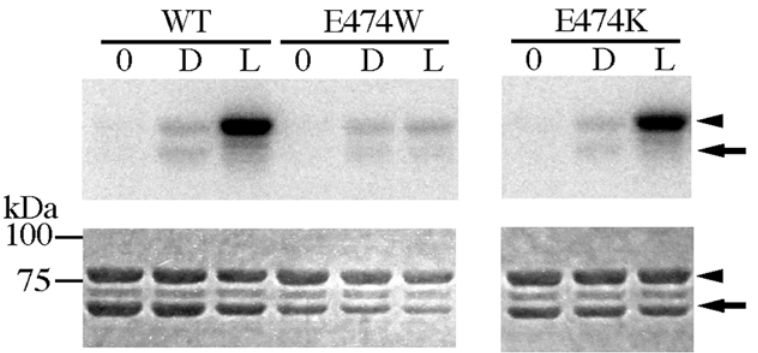
Fig 7. Kinase activity of At phot1 LOV2-STK E474W, (A), and K475K, (B) on P1Nt. 0, D and L indicates before incubation, in the dark and under BL irradiation, respectively. The upper and lower panels indicate autoradiogram and CBB staining of SDS-PAGE gels, respectively. The arrow and the arrowhead indicate the position of LOV2-STK and P1Nt,